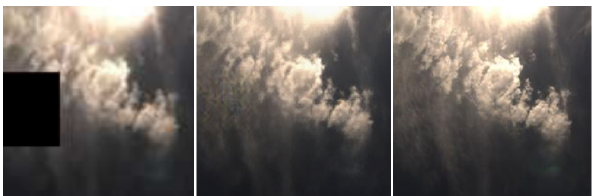
Figure 4. From left to right: input, prediction and ground truth in inpainting–super-resolution pretext